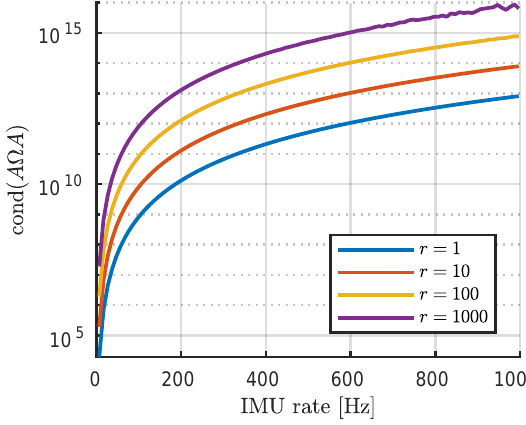
Figure 1. Conditioning number of A T Ω A as a function of 1 { ∆ t and r “ σ x { σ f